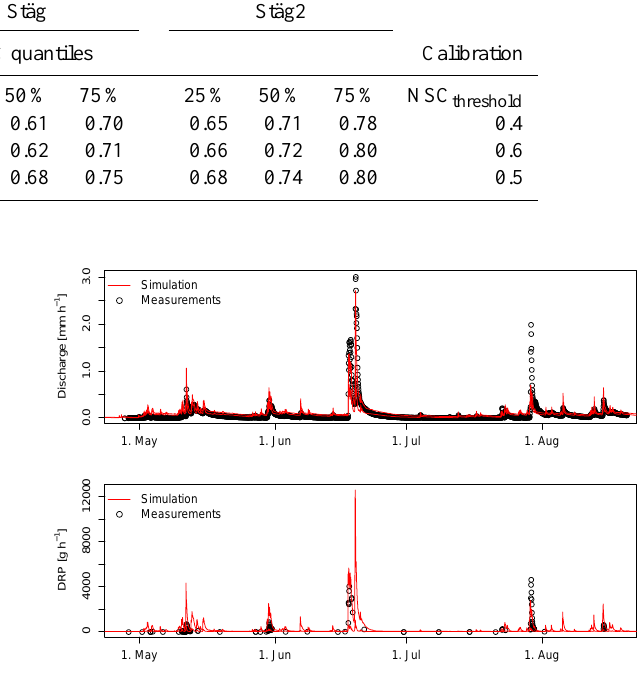
Fig. 4. Simulations (lines, 10% and 90% quantiles) using RRP Ver- sion 2 versus measured (points) discharge and DRP loss from the Stägbach sub-catchment (Stäg2) in 2010.